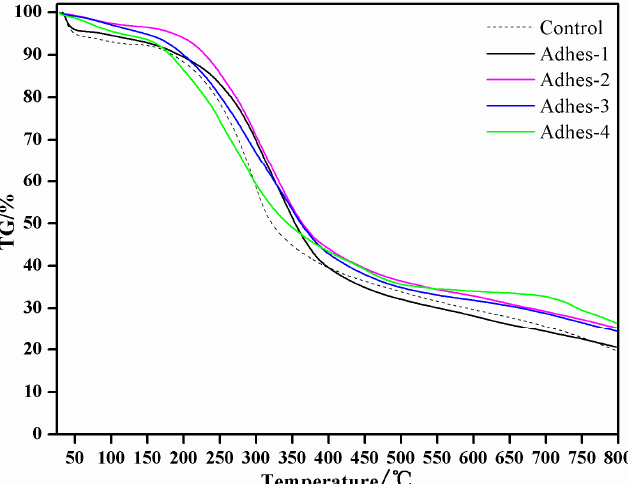
Figure 5. TG results of Camellia oleifera cake-protein adhesives. Note: Control, pure Camellia oleifera cake-protein hydrolysate; Adhes-1, the pure Camellia oleifera cake-protein adhesive; Adhes-2, Camellia oleifera cake-protein adhesive modified with DSP; Adhes-3, Camellia oleifera cake-protein adhesive modified with SPI; Adhes-4, Camellia oleifera cake-protein adhesive modified with casein.